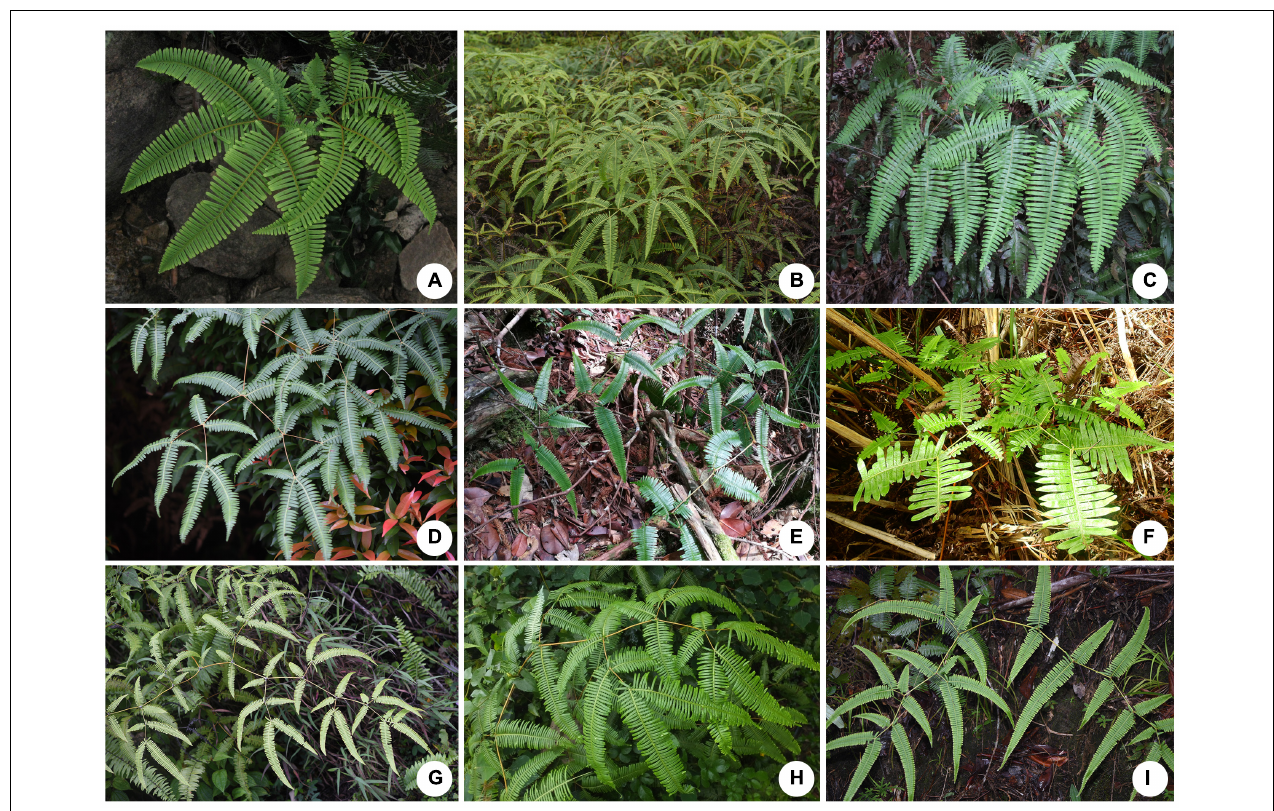
FIGURE 1 | A selection of species of Dicranopteris . (A) D. pedata . (B) D. linearis . (C) D. ampla . (D) D. tetraphylla . (E) D. inaequalis . (F) D. latiloba . (G) D. subpectinata . (H) D. alternans . (I) D. subspeciosa .